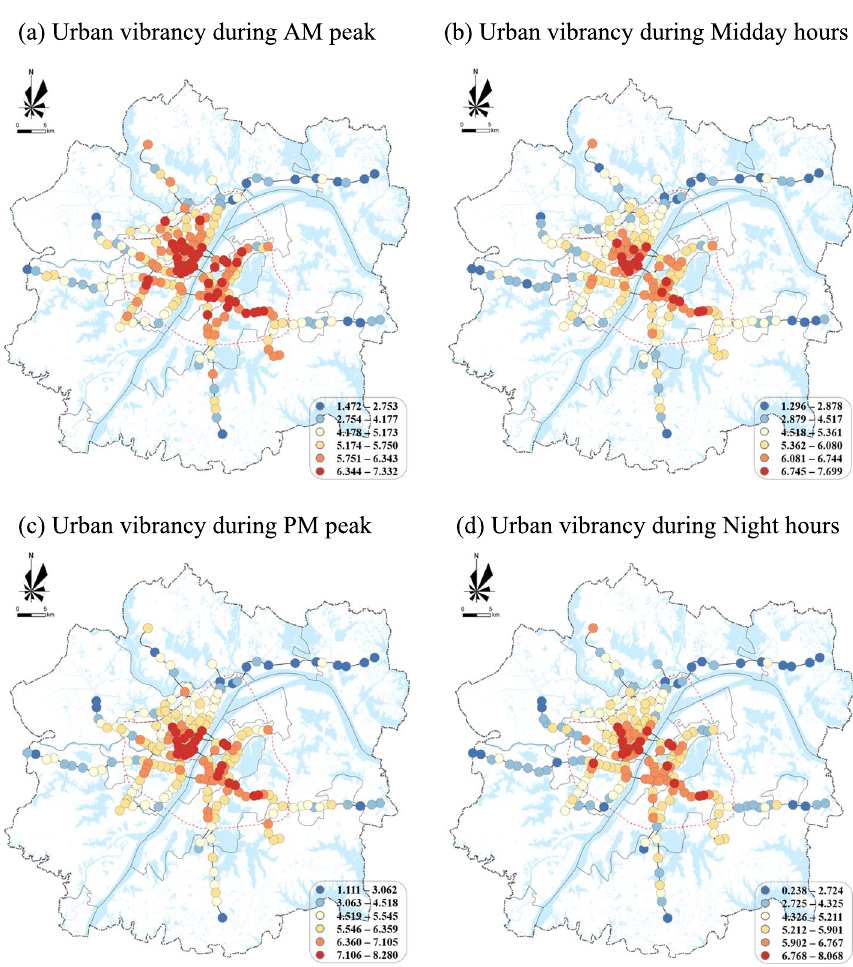
Fig. 3 Urban vibrancy of MSAs during different times in